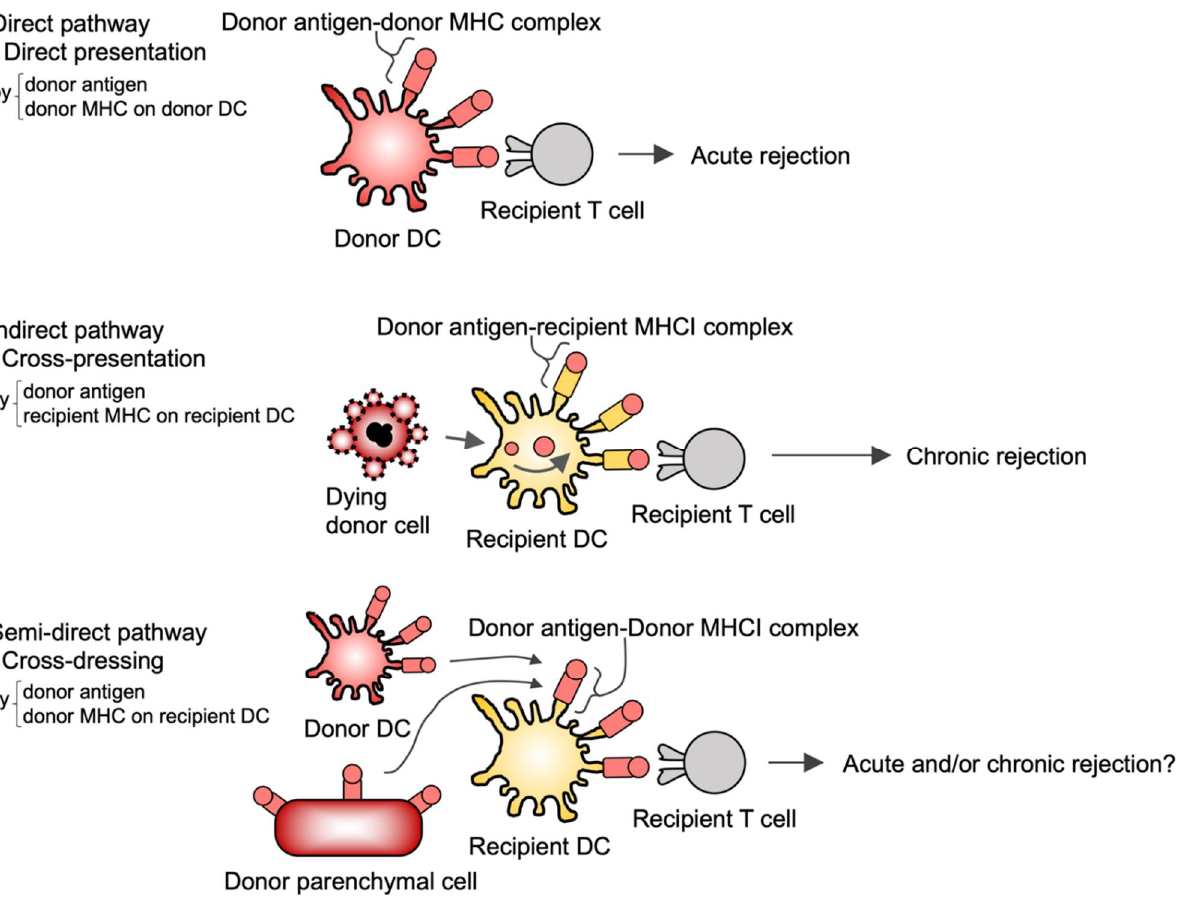
Figure 3. Trogocytosis in allograft transplantation. Alloreactive T cell activation is induced by three pathways. The first is the direct pathway where intact MHC alloantigens on donor DCs are recognized by recipient T cells, promoting acute rejection. The second is the indirect pathway where allograft antigens are internalized and processed by recipient DCs, on which donor antigen-recipient MHC complexes are recognized by recipient T cells, promoting chronic rejection. The third pathway is a semi-direct pathway of so-called cross-dressing where recipient DCs acquire preformed donor antigen-MHC complexes and are recognized by recipient T cells.